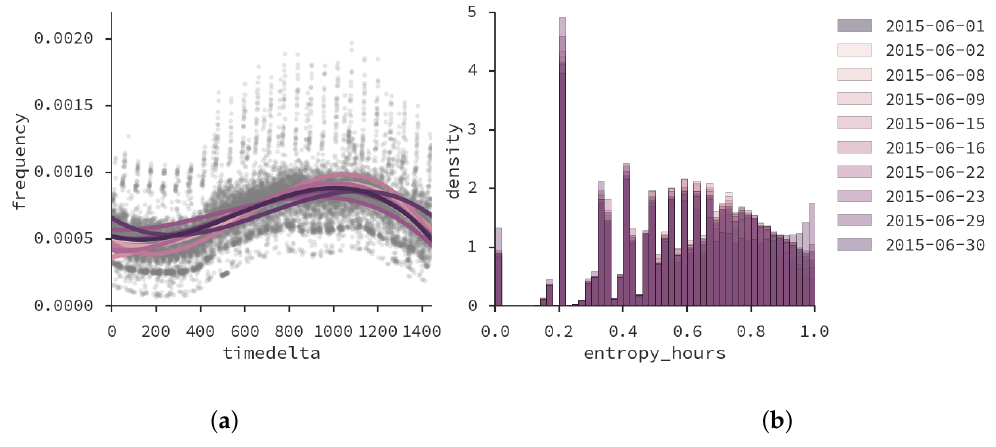
Figure 4. Distributions of Call Detail Records (CDR) event frequency ( a ), and entropy with respect to hours of the day ( b ). Source: [44] (used with